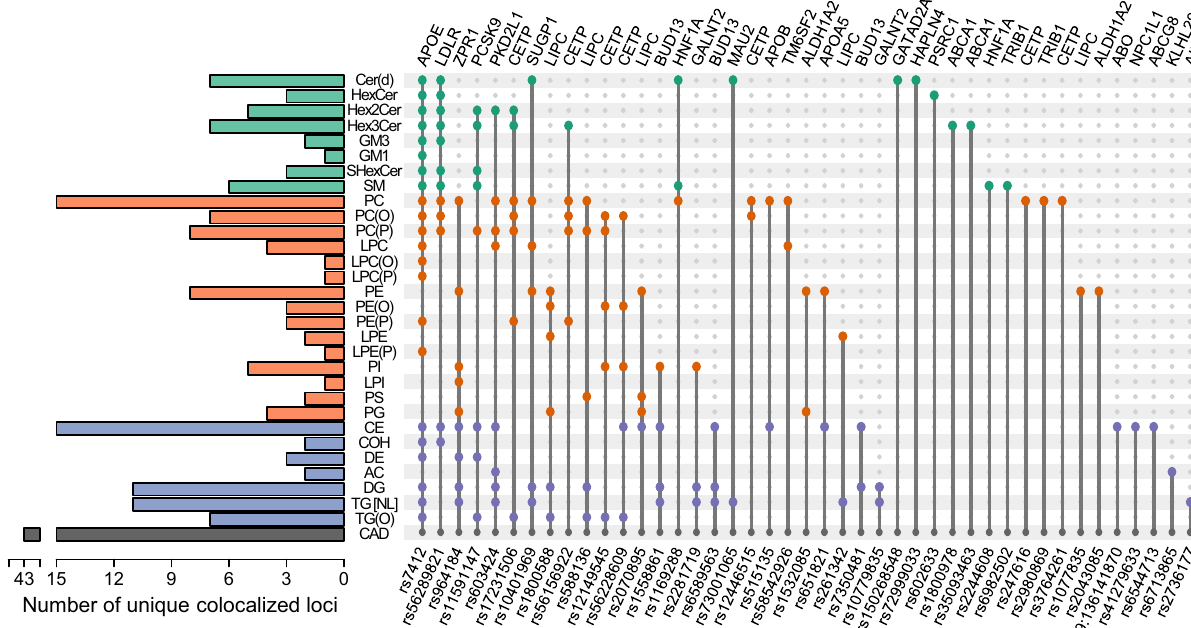
Fig. 6 Co-localisation of lipid-loci with coronary artery disease. Summary of lipid classes which contain at least one lipid specie that co-localises with coronary artery disease. Colours indicate broad lipid categories — green, sphingolipids; orange, phospholipids; blue, neutral lipids/others. Indicated variants were identi fi ed as the most likely causal variant for each of the identi fi ed co-localisation analysis. Genetic variants are ordered according to the number of co-localisations across lipid classes. Evidence of co-localisation included H3 + H4 > 0.8 and H4/H3 >